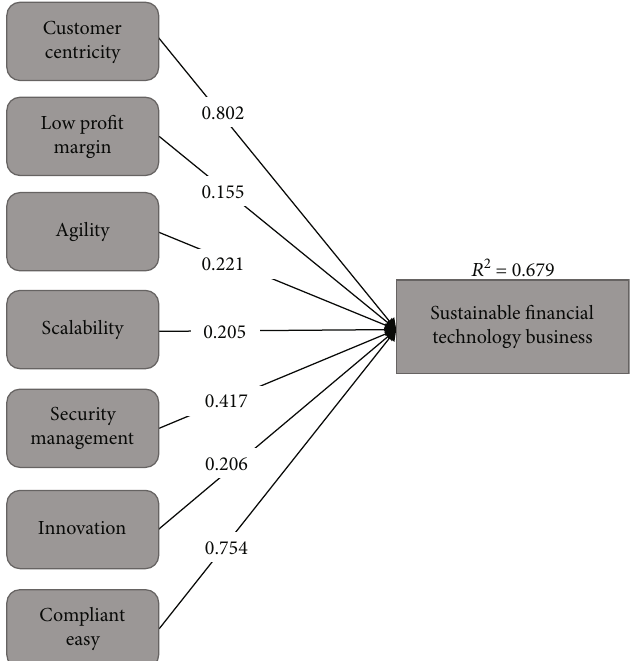
Figure 3: PLS algorithm